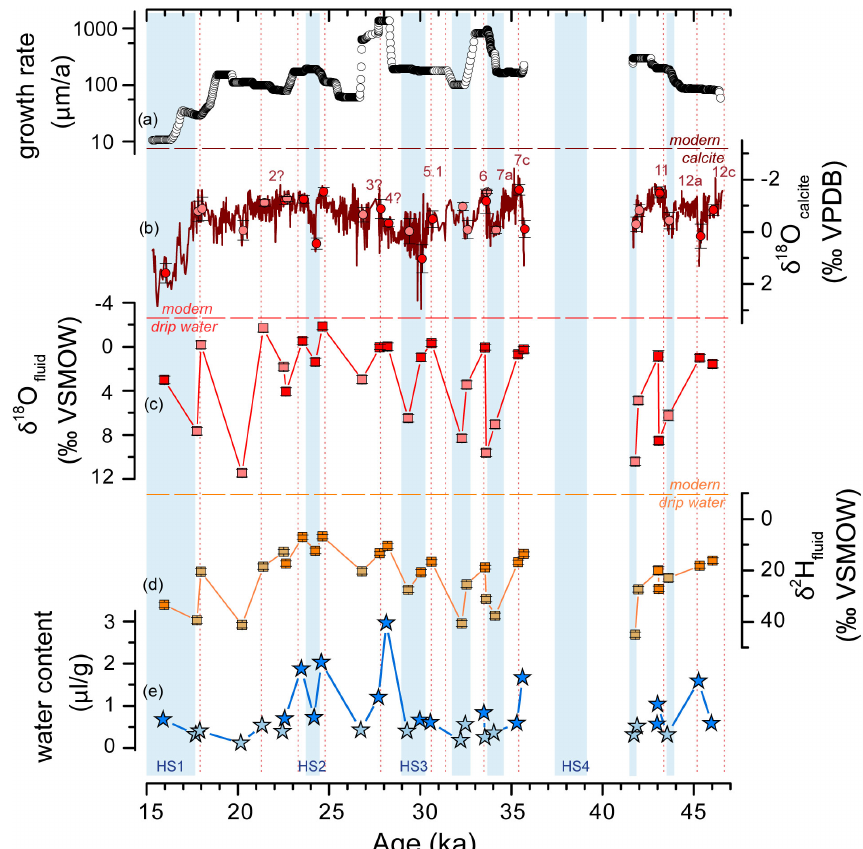
Figure 2. Results of fluid inclusion analysis of stalagmite PR-LA-1 (Table S2). From top to bottom: (a) growth rate (logarithmic scale) and (b) δ 18 O c values from Warken et al. (2020). Symbols indicate the averaged δ 18 O c values used for each depth of fluid inclusion isotope analysis respectively. Vertical blue bars (dotted red lines) indicate the timing of cool/dry (warm/humid) periods, such as HS 1 to 3 (Greenland interstadials (GIs) 12c to 6) in the western tropical Atlantic (Warken et al., 2020). The following panels show fluid inclusion isotope values of (c) δ 18 O f , (d) δ 2 H f , and (e) measured water content. Symbol colours indicate the samples with high (dark coloured symbols) and low (light coloured stars) water content, with a threshold value of 0.55µLg − 1 respectively. Horizontal lines indicate modern cave conditions. Note that the axes of the δ 18 O c , δ 18 O f , and δ 2 H f values are